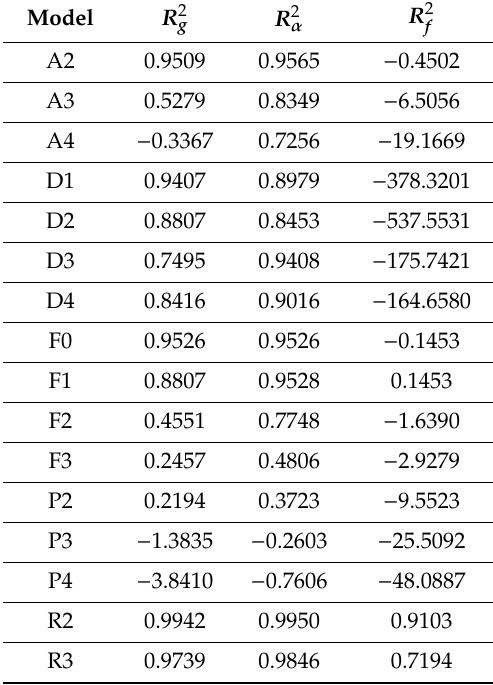
Table 3. The determination coe ffi cients calculated at every step of the COMF method in the case of the desolvation of methanol solvates of ciclesonide at 115 ◦ C.